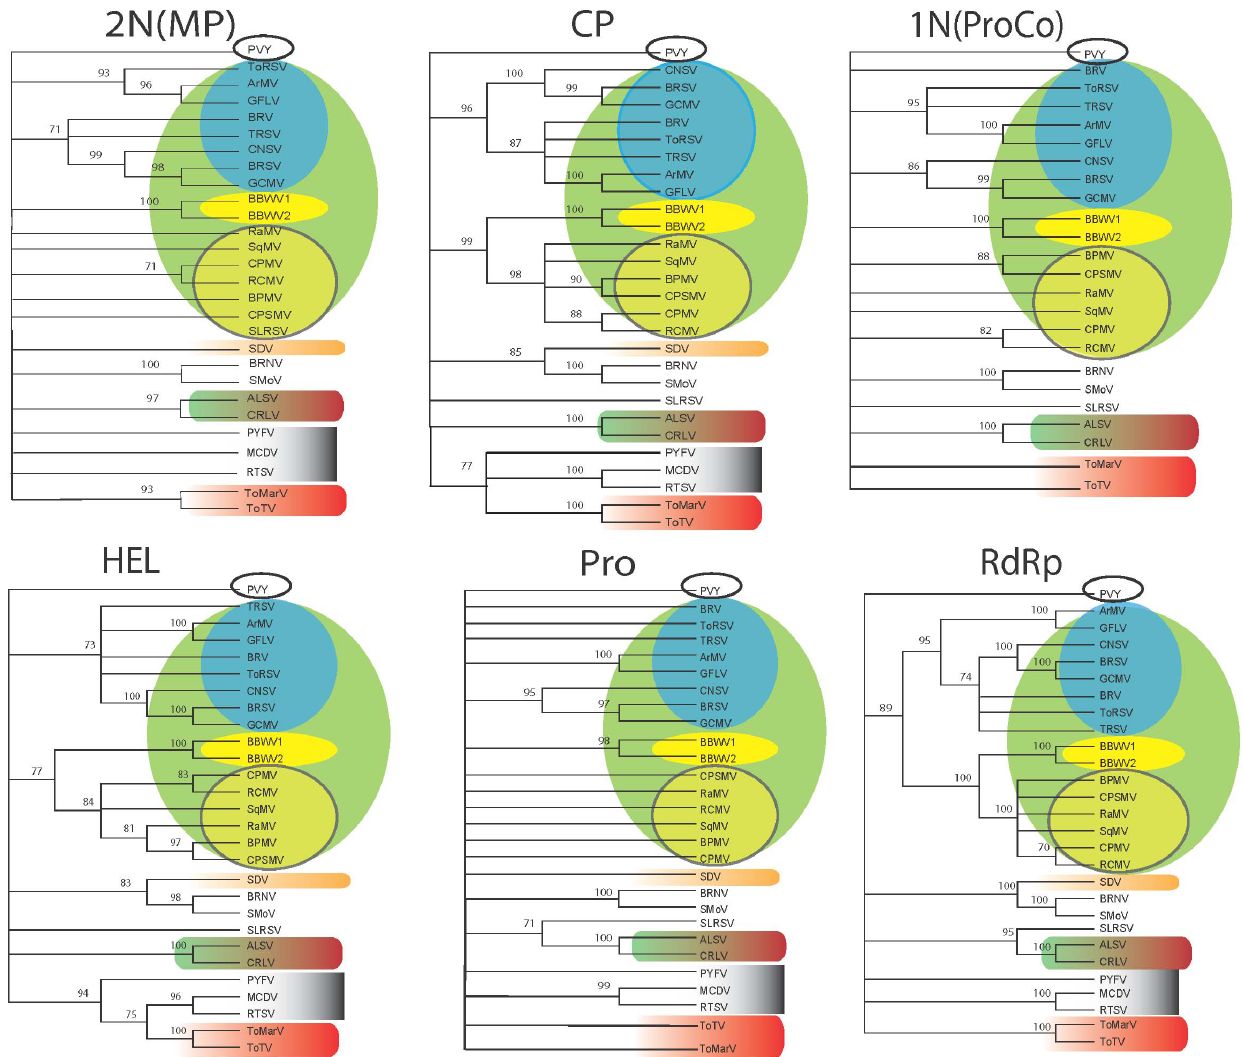
Figure 4. Maximum likelihood inferred phylogenetic trees for the six main functional domains of the Secoviridae . The putative movement protein or 2N terminal protein, 2N(MP); the coat protein (CP); the putative protease cofactor or 1N terminal protein, 1N(ProCo); the helicase (HEL), the protease (Pro), and the RNA-dependent RNA polymerase (RdRp). Designated viral lineages are contained within the polygons, in descending order: green, Comovirinae ; blue, Nepovirus ; yellow, Fabavirus ; yellow/green, Comovirus ; orange, Sadwavirus ; red/green, Cheravirus ; grey, Sequivirus, Waikavirus ; red, Torradovirus . Numbers at nodes refer to bootstrap values, with any branch below 70% being collapsed. The outgroup (black oval) for all trees is the corresponding functional gene of the Potato virus Y (PVY). PVY is type member of the potyvirus genus in the Potyviridae family – a group of plant infecting picorna-like viruses that lies outside the Picornavirales order [74]. Apple latent spherical virus (ALSV), Arabis mosaic virus (ArMV), Bean pod mottle virus (BPMV), Beet ringspot virus (BRSV), Black raspberry necrosis virus (BRNV), Blackcurrant reversion virus (BRV), Broad bean wilt virus-1 (BBWV1), Broad bean wilt virus-2 (BBWV2), Cherry rasp leaf virus (CRLV), Cowpea mosaic virus (CPMV), Cowpea severe mosaic virus (CPSMV), Cycas necrotic stunt virus (CNSV), Grapevine chrome mosaic (GCMV), Grapevine fanleaf virus (GFLV), Maize chlorotic dwarf virus (MCDV), Parsnip yellow fleck virus (PYFV), Radish mosaic virus (RaMV), Red clover mottle virus (RCMV), Rice tungro spherical virus (RTSV), Satsuma dwarf virus (SDV), Squash mosaic virus ( SqMV), Strawberry mottle virus (SMoV), Strawberry latent ringspot virus (SLRSV), Tobacco ringspot virus (TRSV), Tomato marchitez virus (ToMarV) and Tomato ringspot virus (ToRSV), Tomato torrado virus (ToTV).